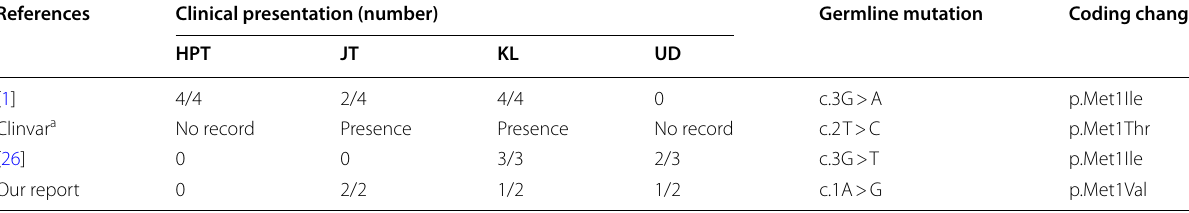
HPT Hyperparathyroidism, JT Jaw tumor, KL Kidney lesion, UD Uterine disease Presence, presented with Nephroblastoma and Ossifying fibroma of the jaw, but the number is not referred to. No record; HPT or UD-related diseases is not recorded in databases a National Center for Biotechnology Information. ClinVar; [VCV000521635.2], https:// www. ncbi. nlm. nih. gov/ clinv ar/ varia tion/ VCV00 05216